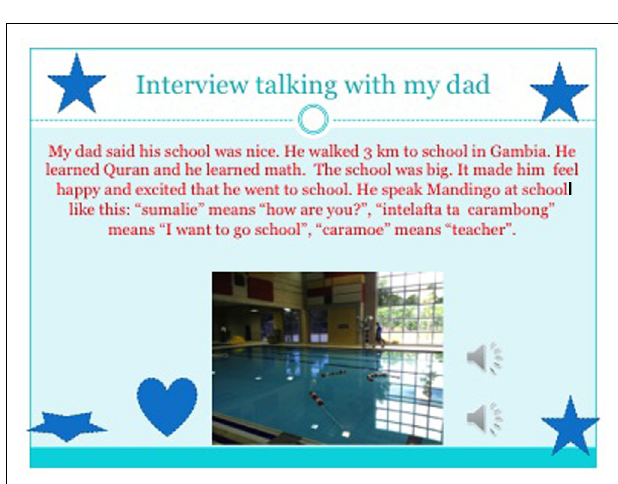
FIGURE 5 |Another slide from Fatu’s PowerPoint